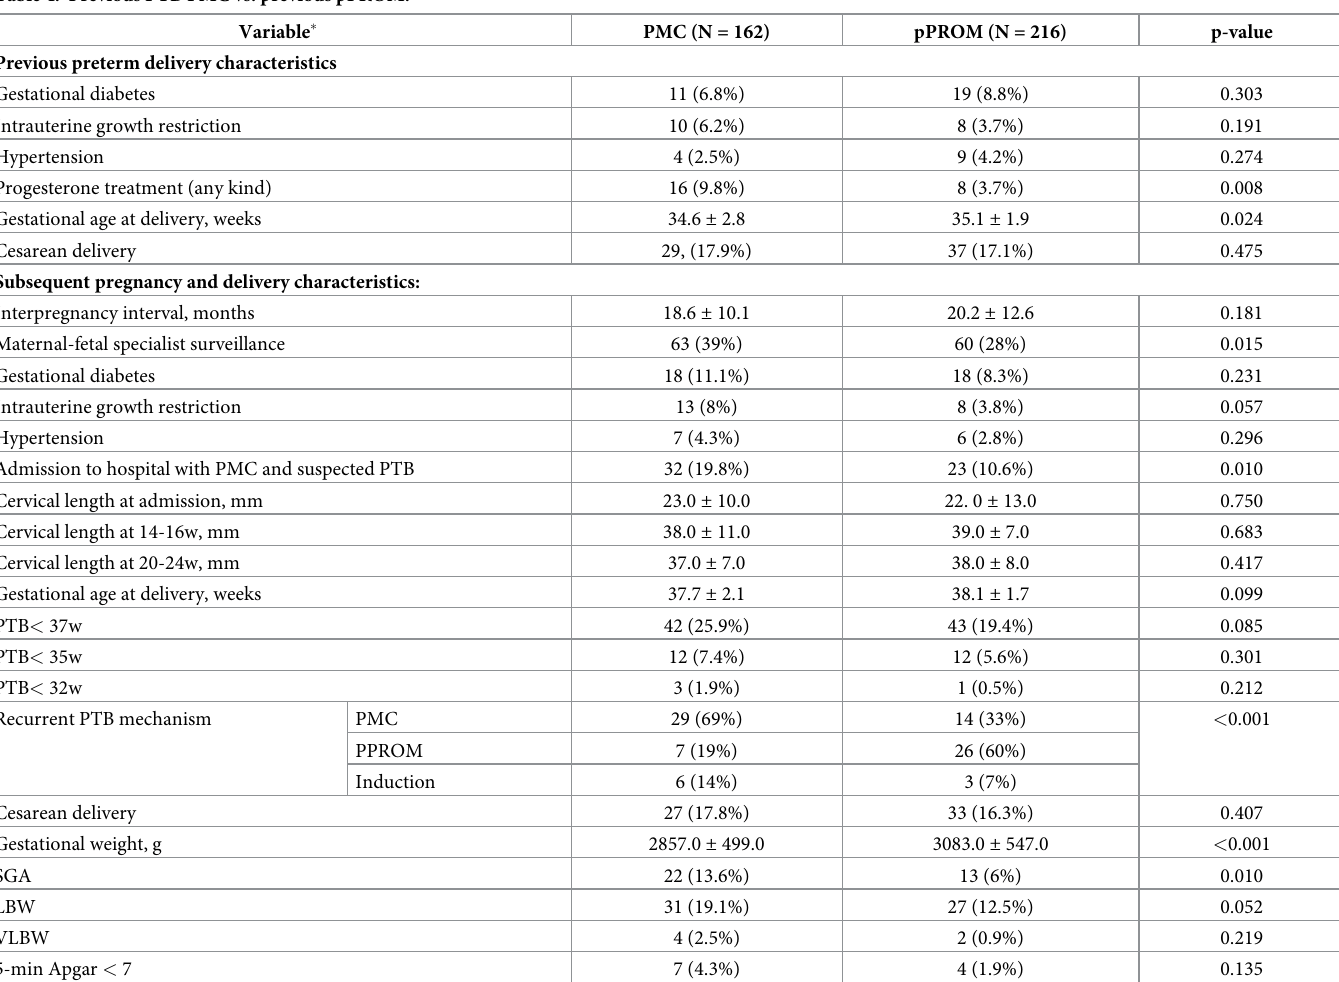
Table 4. Previous PTB PMC vs. previous